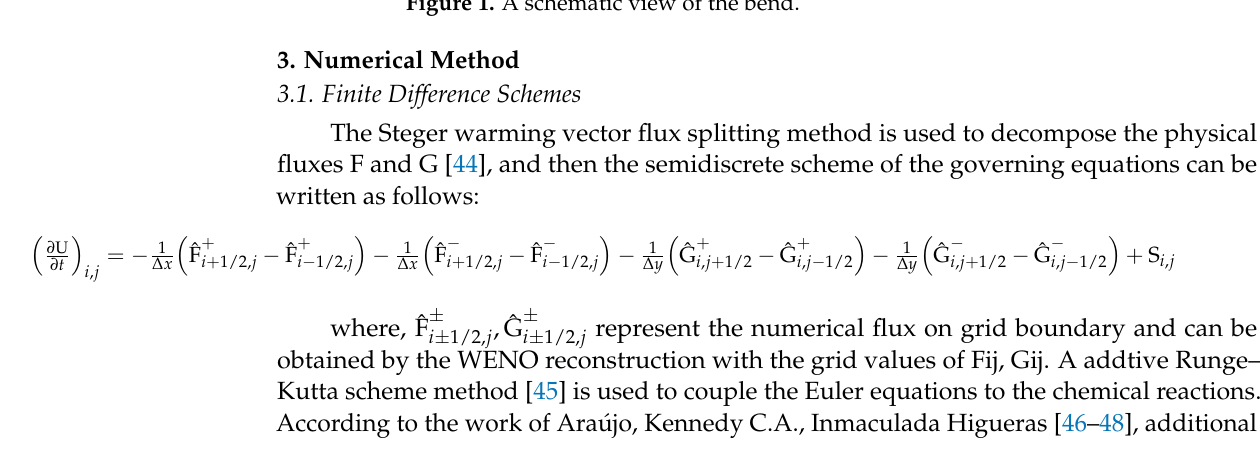
Figure 1. A schematic view of the bend.